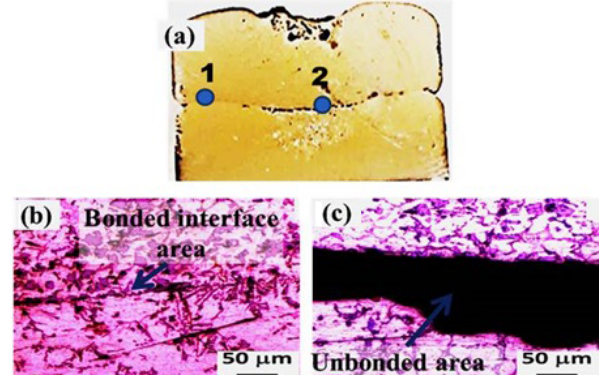
Figure 4. Macro- and microstructure of bimetal casting for a 20s time interval. (a) Macrophotograph cross section. (b, c) Represen- tation of the microstructures of points 1 and 2, respectively.